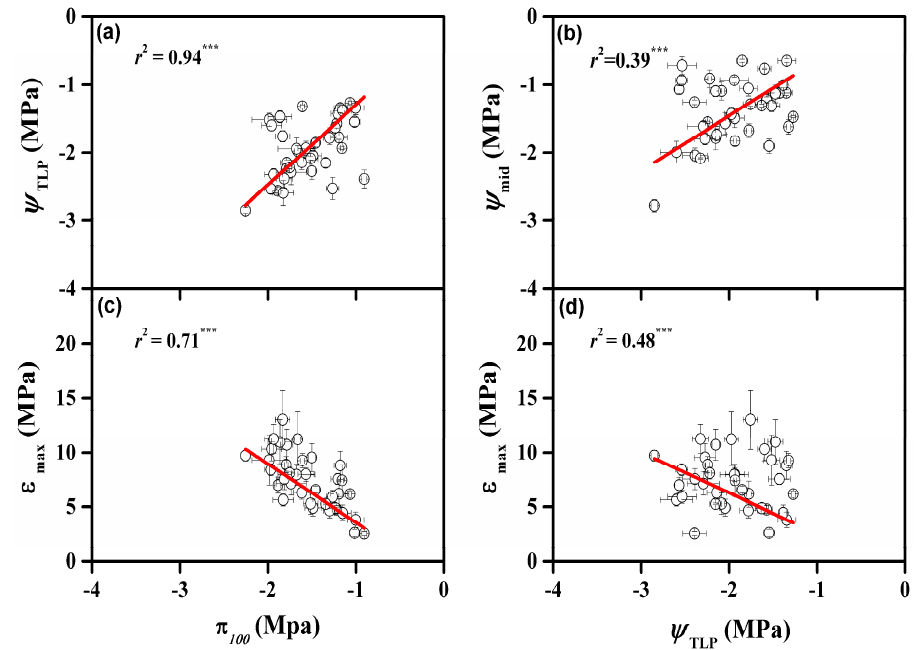
Figure 4. Correlations between osmotic potential at full turgor ( π 100 ) and ( a ) turgor loss point ( Ψ TLP ) and ( c ) modulus of elasticity ( ε max); and the correlations between turgor loss point ( Ψ TLP ) and ( b ) midday leaf water potential ( Ψ mid ) and ( d ) ε max . Solid lines represent the linear regressions, and the associated r 2 values are provided (* P < 0.05, ** P < 0.01, *** P < 0.001). Data are means ± 1 SE.